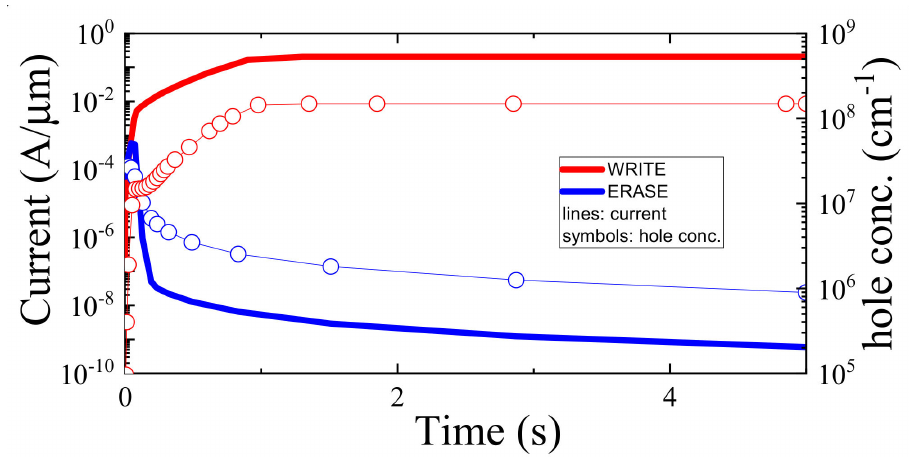
Figure 4. ( left axis ) current and ( right axis ) hole concentration during WRITE (V D = − V G = 2 V) and ERASE (V G = V D = 0) operations. The hole concentration is integrated in the channel and in the body raised region ( − L /2 ≤ x ≤ L /2).